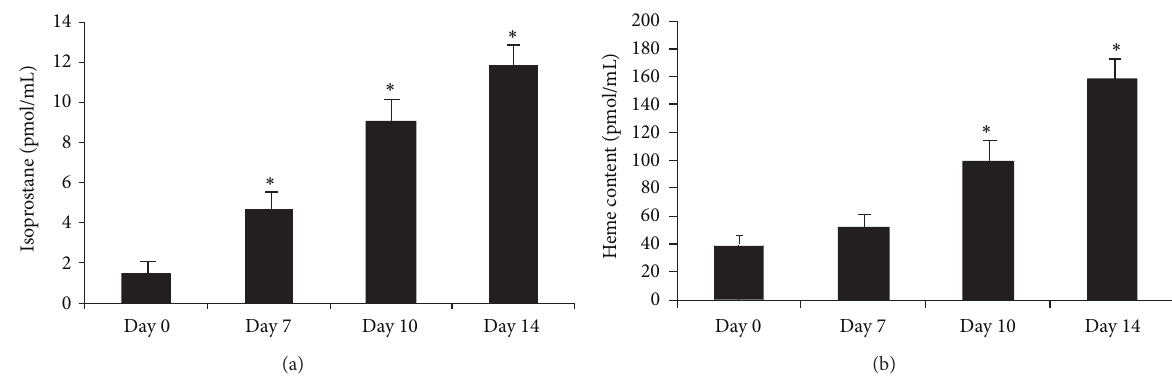
Figure 2: Measurement of 8-isoprostane in conditioned media and heme content in pelleted cells at days 0, 7, 10, and 14 of adipogenesis in human MSCs treated with 500 𝜇 M fructose (Figures 2(a) and 2(b), resp.). Values represent means ± SEM of five independent treatments. ∗ 𝑃 < 0.05 versus control.